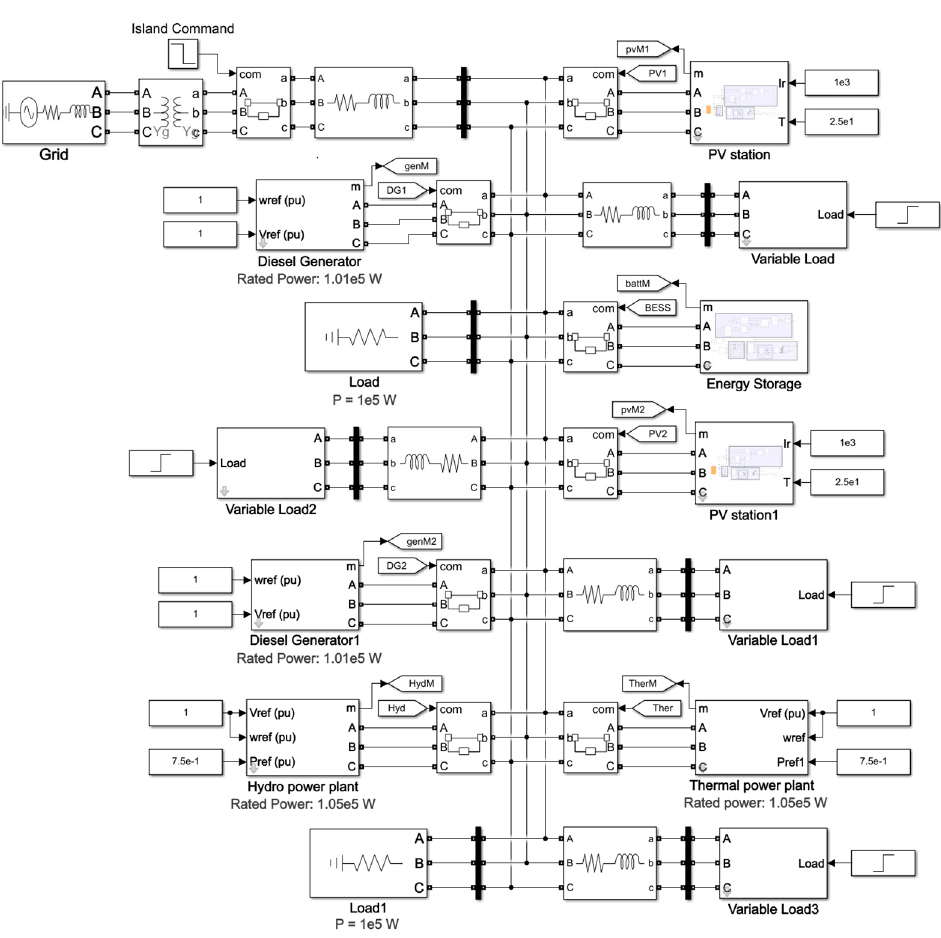
Figure 29. Microgrid model with renewable energy sources.